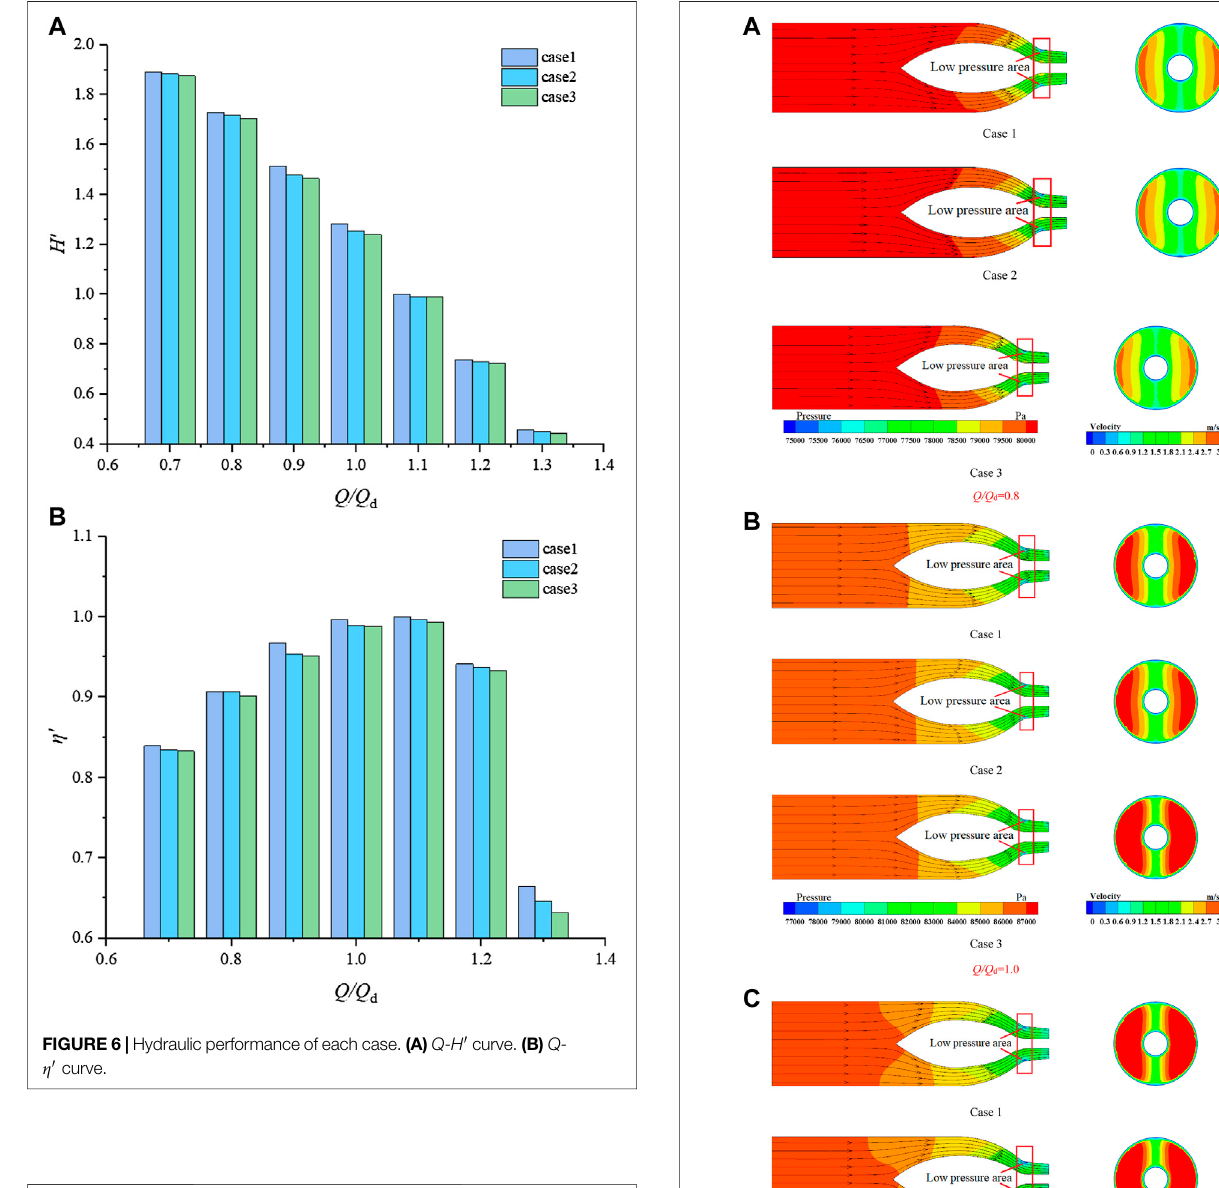
Frontiers in Energy Research |